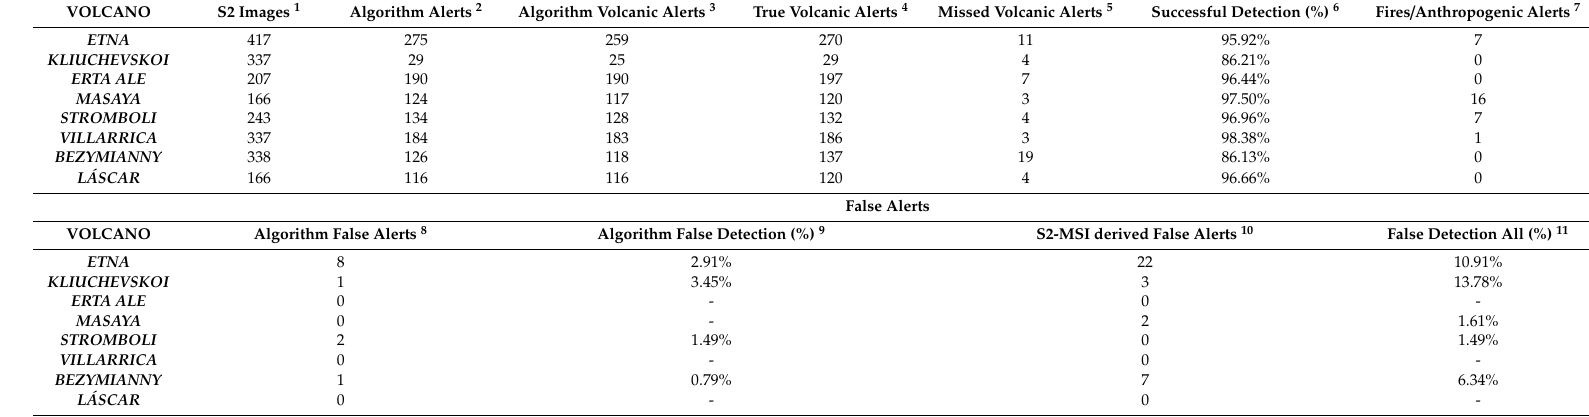
Table 2. Results of evaluation of the SENTINEL-2 hot-spot algorithm. 1 N. images analyzed; 2 N. images with at least one alert detected by the algorithm; 3 N. images with at least one true volcanic alert detected by the algorithm; 4 N. images with at least one true volcanic alert; 5 N. images with at least one true volcanic alert missed by the algorithm; 6 Percentage of successful detections = ( Algorithm volcanic alerts / True volcanic alerts) * 100 ; 7 N. images with at least one fire / human-related alert detected by the algorithm; 8 N. images with at least one false alert detected by the algorithm. 9 Percentage of false detections = ( Algorithm false alerts / Algorithm alerts) * 100 ; 10 N. images with at least one false alert related to S2-MSI sensor artifacts detected by the algorithm; 11 Percentage of false detections considering also the